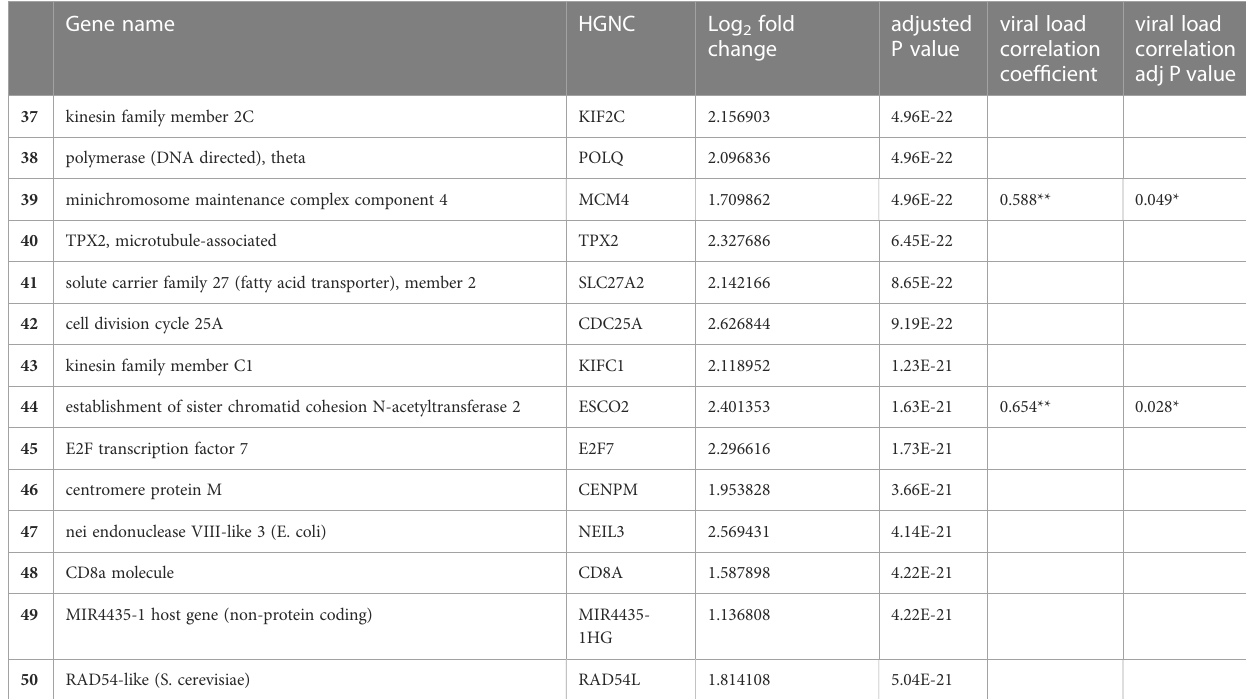
HIV negative controls, at 37.8% (p<0.001), 5.0% (p<0.001), and 6.5% (p=0.028) respectively. Other cell populations were not signi fi cantly different between groups. These estimated data were validated by correlating with CD4+ and CD8+ counts via fl ow cytometry, with moderate Spearman correlations of 0.645 and 0.705 respectively (both p<0.001) (Figures 5B, C).